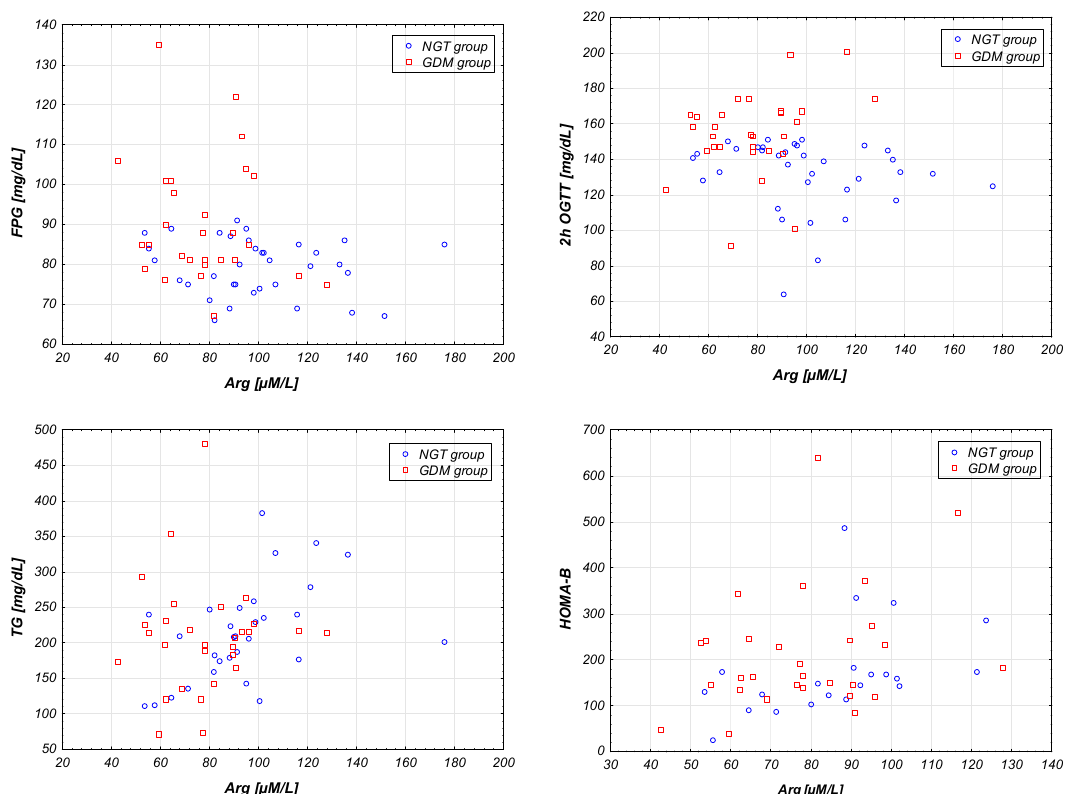
Figure 7. Scatter plots imaging the strongest correlations between arginine concentration and biochemical characteristics (FPG, OGTT 120, TG, HOMA-B) of studied pregnant NGT and GDM women ( n = 64).